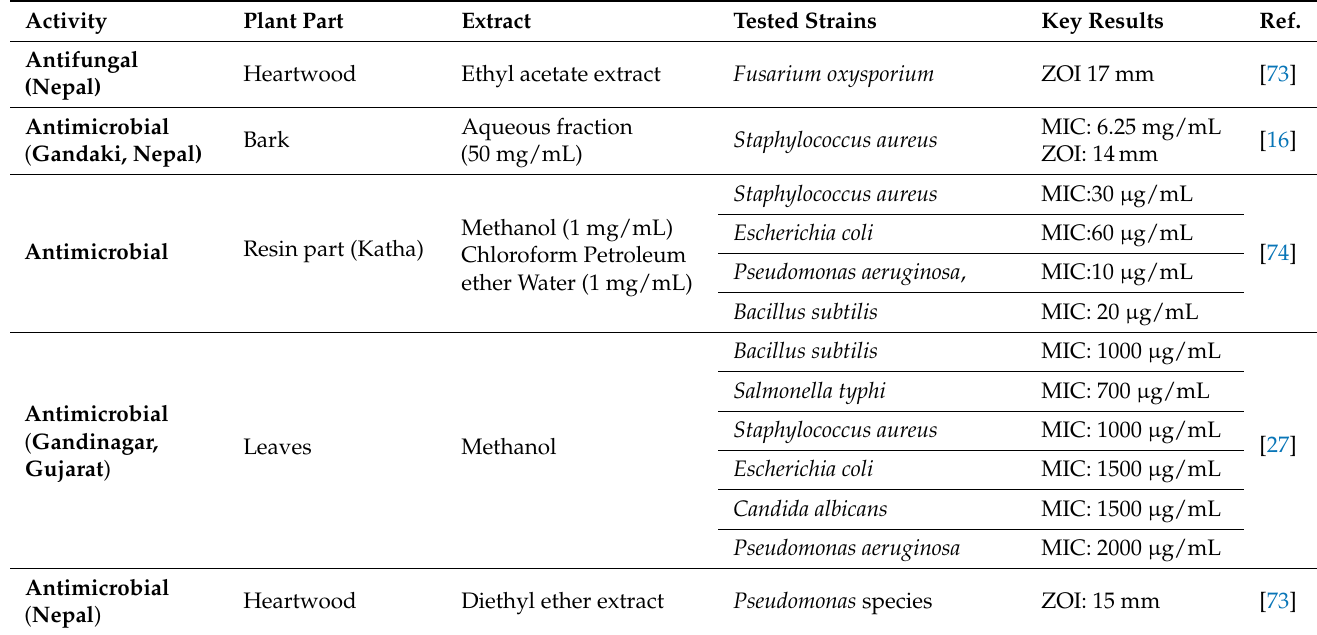
Table 6. Antimicrobial and antifungal activities of different parts of the Acacia catechu plant parts using agar well diffusion and disc diffusion